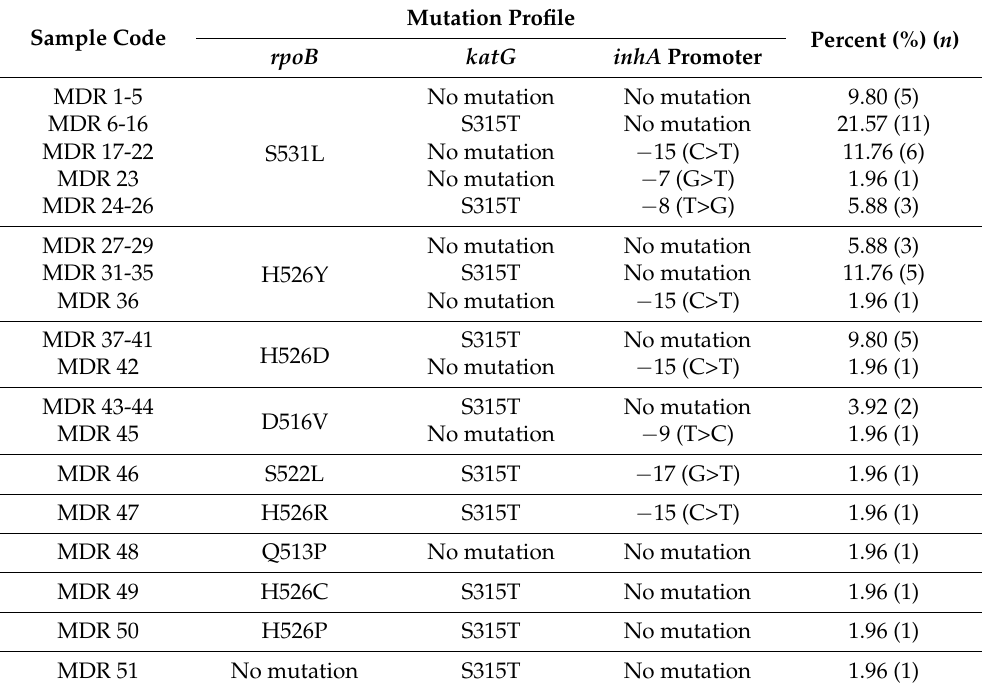
Table 2. The genotype of 51 multidrug-resistant Mycobacterium tuberculosis isolates in upper north- ern Thailand. Sample